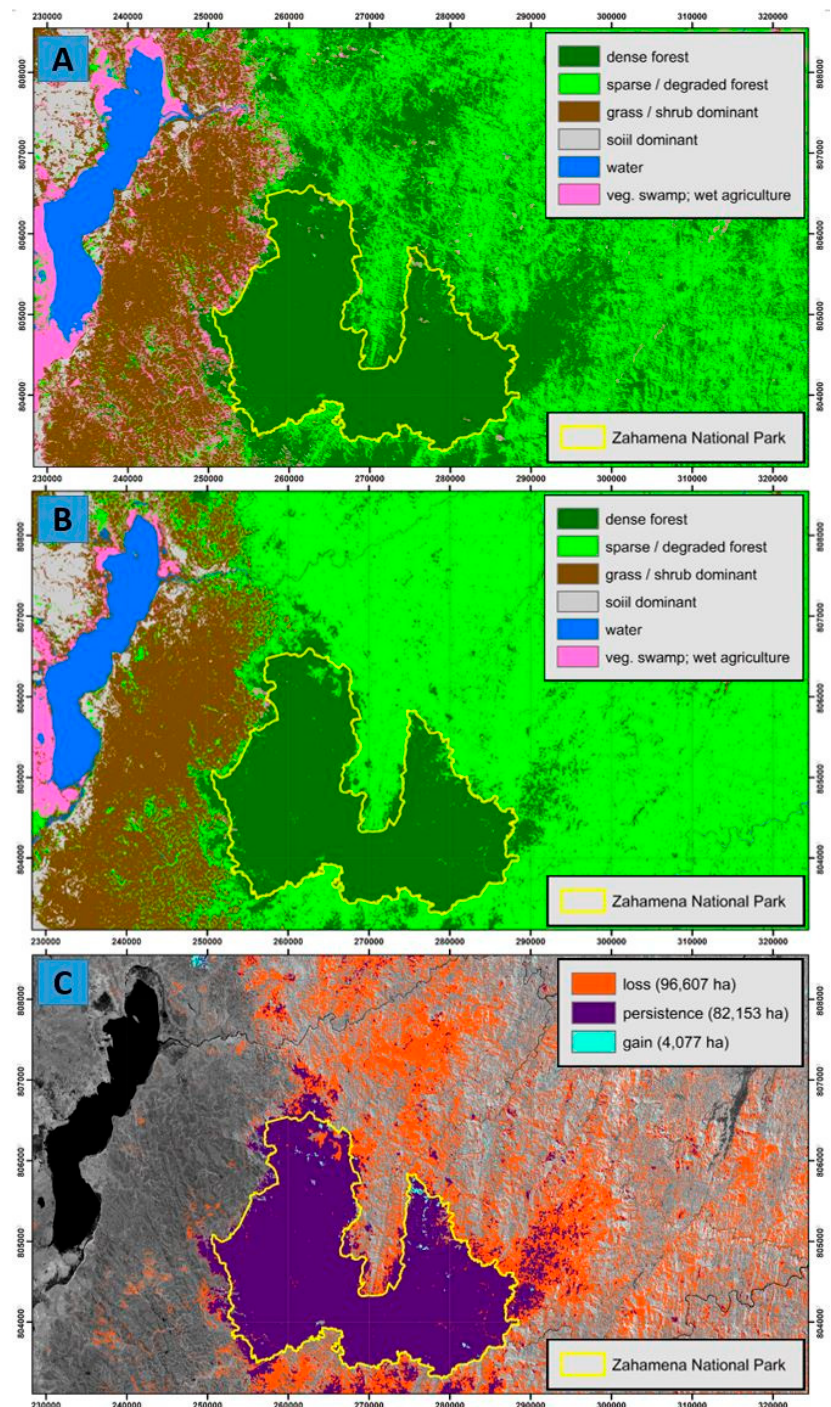
Figure 6. Supervised maximum-likelihood classification results of Landsat imagery showing the distribution of targeted land-cover classes in the study area for June 1990 (Panel A) and August 2014 (Panel B). Panel C shows loss, persistence, and gain in dense forest from 1990–2014 in and around the Zahamena National Park. The background image is the near-infrared (NIR) band of Landsat imagery from August 2014. The boundary for the Zahamena National Park appears in yellow in all panels. The coordinates for all panels are Universal Transverse Mercator (UTM) Zone 39 South.